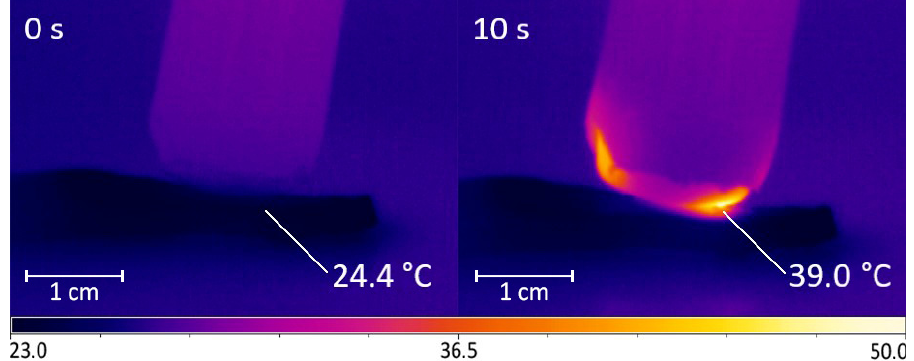
Figure 4. Changing the surface temperature of a pear branch cut during treatment using DBD CAP. During 10 s of exposure, surface temperature rose by (14.6 ± 2.0) °C. Number of repetitions was 5.